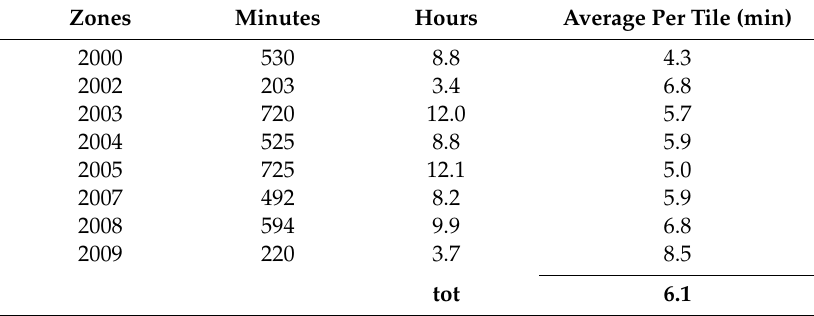
Table 4. RF processing time divided by zone of